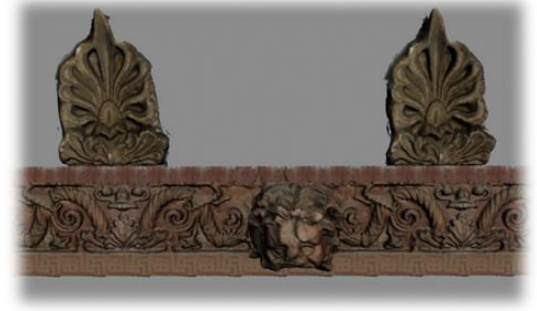
Figure 8: Part of the Sima of the Middle Stoa